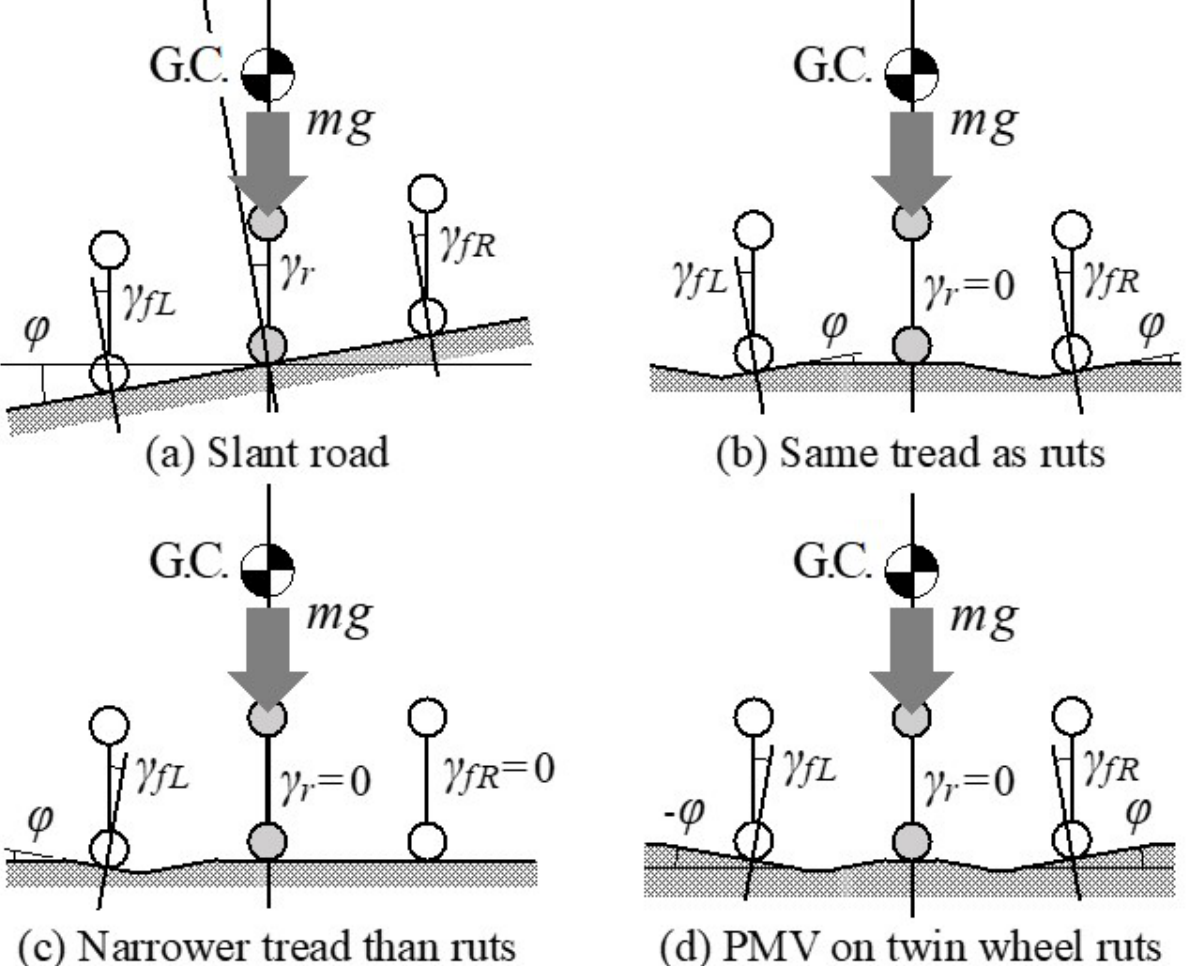
Figure 20. PMV running on a slanted road and typical rutted roads. In order to maintain straight running without being disturbed by the transverse slope of the road surface in any of these inconsistent situations, the lateral force generated by the transverse slope of the road surface and the moment around the steering axis should not be canceled between the left and right wheels and lateral force and the moment must be avoided independently in each wheel. As mentioned in the discussion of straight running ability on slanted roads, if each of the both wheels independently minimize disturbances in terms of both the lateral force on slanted roads and the moment around the steering axis, straight running ability is maintained even under all ruts